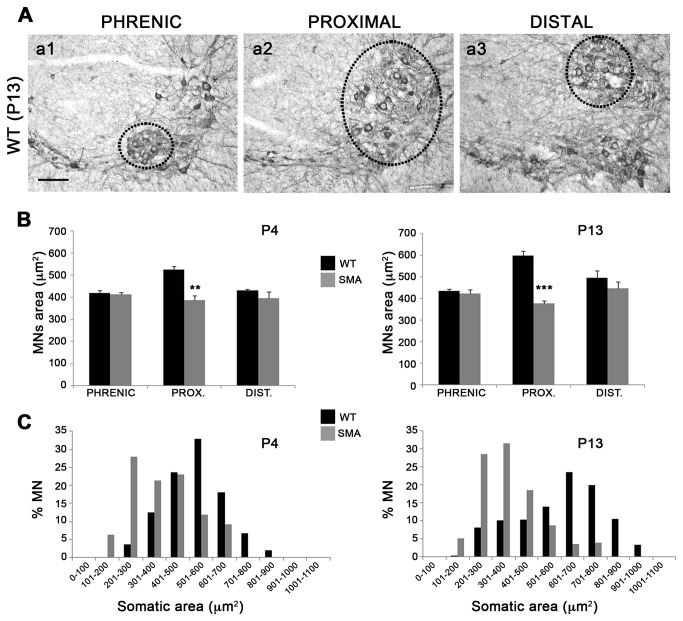
Selective loss of proximal motor neurons.(A) Representative ChAT reacted coronal sections of the cervical spinal cord illustrating 3 different motor neuron (MN) pools (hatched lines) in WT at P13: phrenic MNs at C3 level (a1), lateral MNs at C5-C6 innervating forelimb proximal muscles (a2), and lateral MNs at C8 innervating forelimb distal muscles (a3). (B) Quantitative analysis of mean areas of the 3 MN pools in SMA vs WT mice revealed a significant soma size reduction only in the MN pool innervating proximal forelimb muscles (left, P4: 386.3 ± 22.5 µm2 in SMA vs 526.5 ±15 µm2 in WT, **p < 0.01, t-test; right, P13: 378 ± 13 µm2 in SMA vs 599.7 ± 20.7 µm2 in WT, ***p < 0.001). Mean area were unchanged in phrenic MNs (left) and not significantly reduced in MNs innervating distal muscles (right). (C) The analysis of soma size distribution of MNs innervating proximal muscles revealed a significant shift to lower size in SMA vs WT mice at P4 (left) and even more at P13 (right) (***p<0.001, chi-square test between WT and SMA curves). Values are expressed as mean ± SEM. Scale bar: 100 µm.